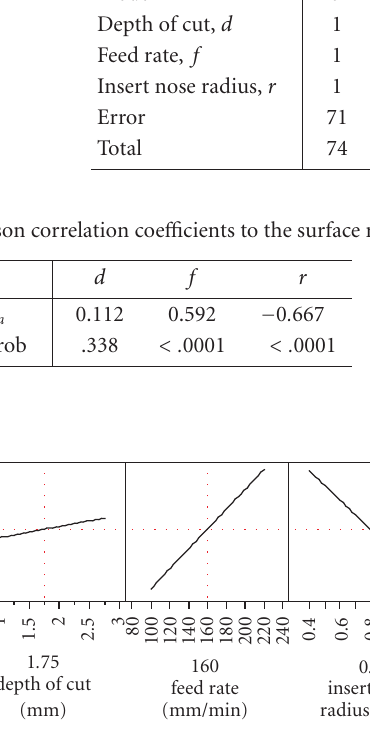
Figure 4: The main e ff ect plots of depth of cut, feed rate, and insert nose radius on the surface roughness.